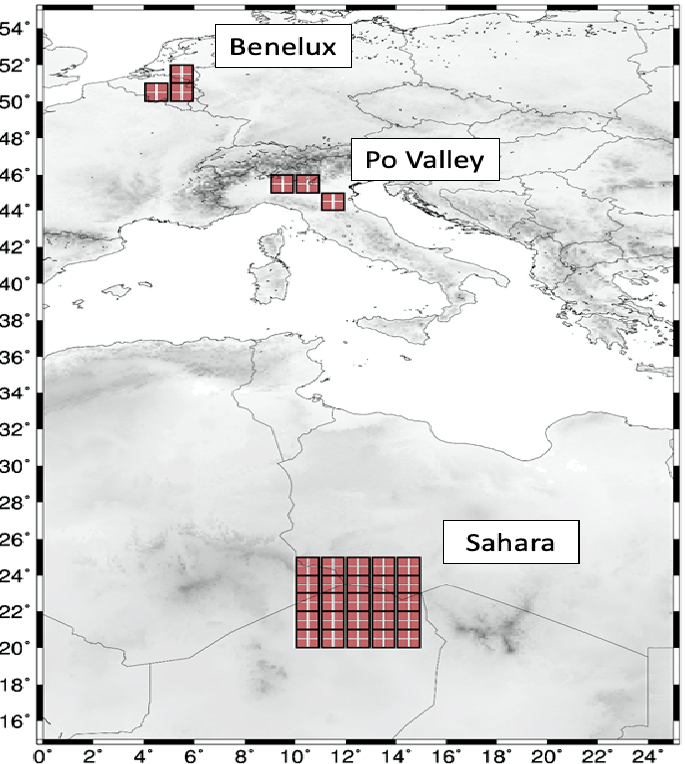
Figure 1. Regions Of Interest (ROI) considered for this study. From north to south: Benelux, Po Valley, and portions of of Sahara desert. The red boxes depict the areas considered for calculating the mean of the geophysical parameters taken into account for this study and described in the